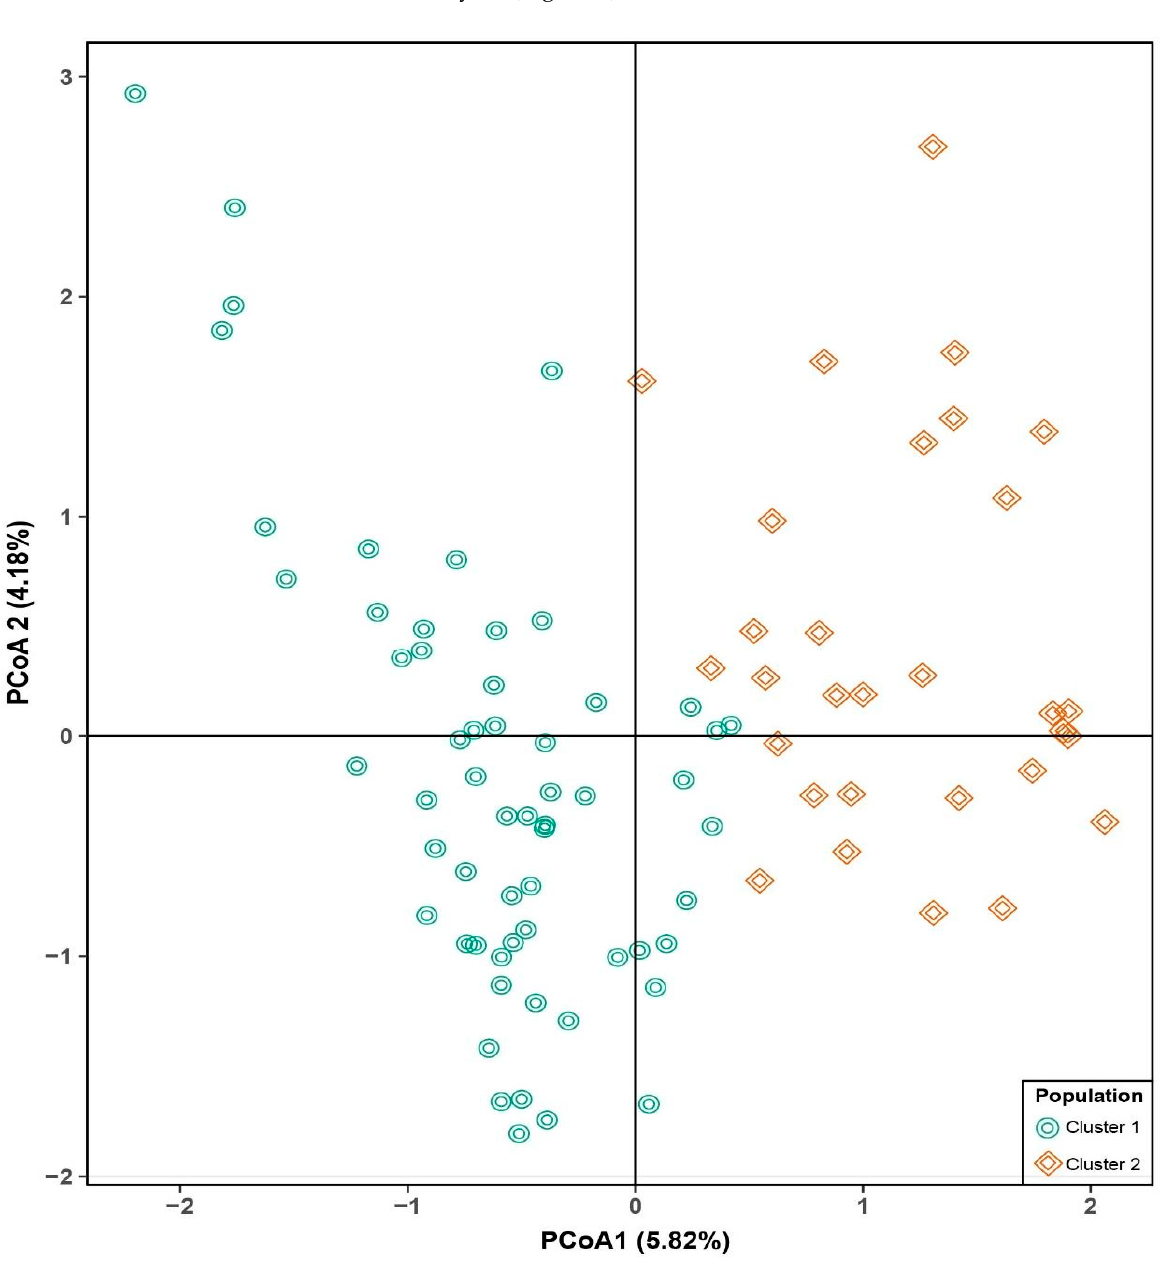
Figure 3. Principal coordinate analysis (PCoA) of 89 samples of Peruvian tarwi germplasm. Percent- ages of variance explained by each coordinate are noted in parentheses.